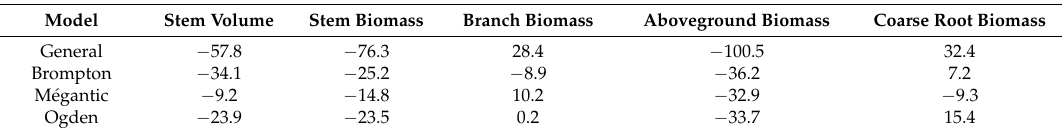
allometric models developed for the different tree compartments.